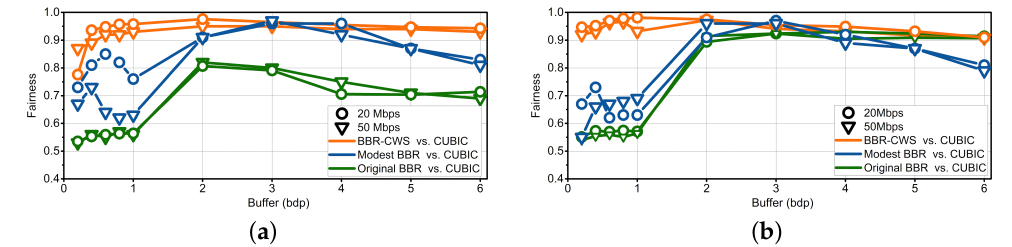
Figure 13. The fairness between BBR and CUBIC by the buffer size: ( a ) short latency (10 ms); and ( b ) long latency (40 ms).